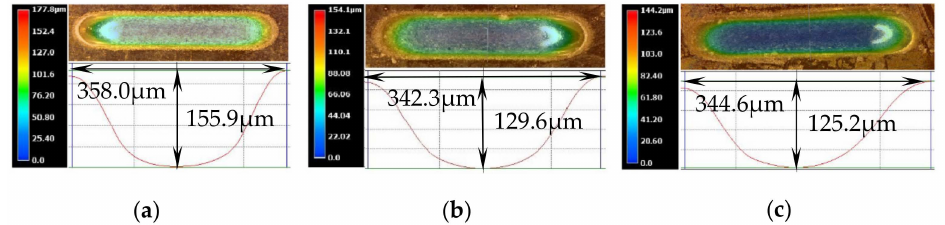
Figure 14. 3D topographies of the micro-grooves machined with the translating mode produced when the electrical voltage was 30 V, the translating speed was 200 µ m / s, the nozzle inner diameter was 170 µ m, and working gap was 100 µ m. ( a ) Vertically downstream mode; ( b ) translating vertically in horizontal mode; ( c ) translating horizontally in horizontal mode.